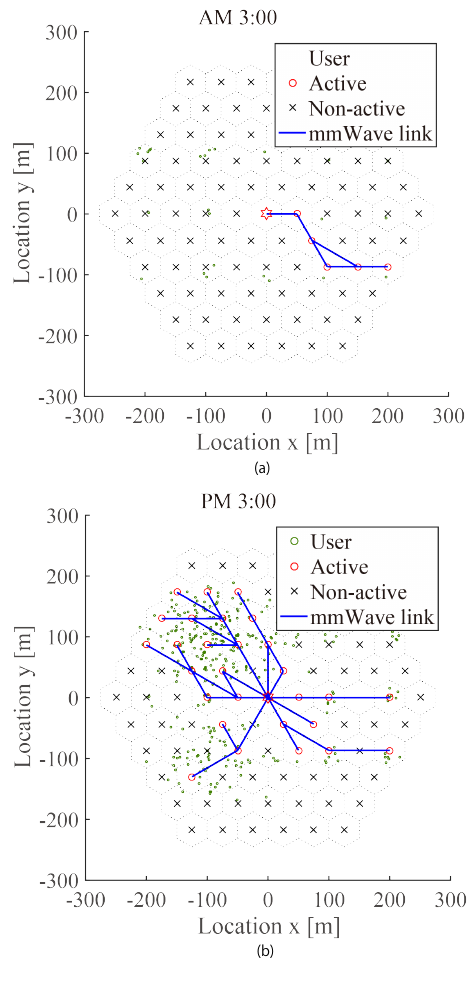
Figure 7. Example of traffic adaptive formation of mmWave meshed backhaul. ( a ) Formed mmWave